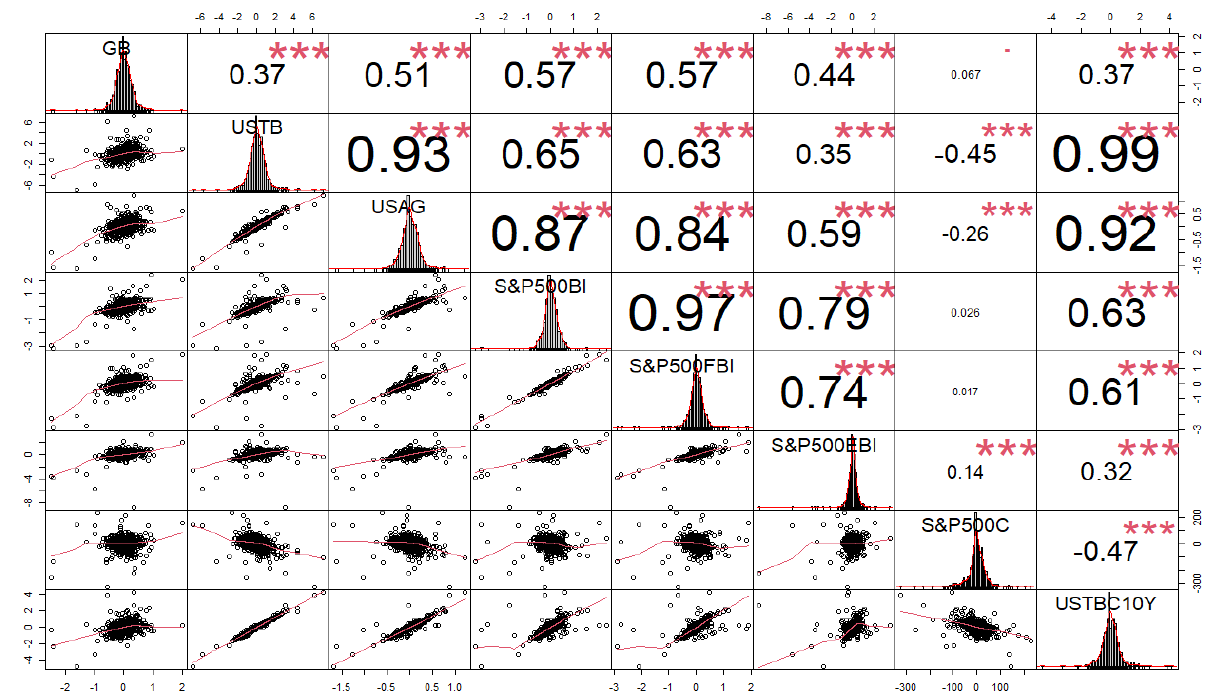
Figure 2. Pairwise correlation and distribution with smoothed trend lines. Note *** represent 1% significance level.